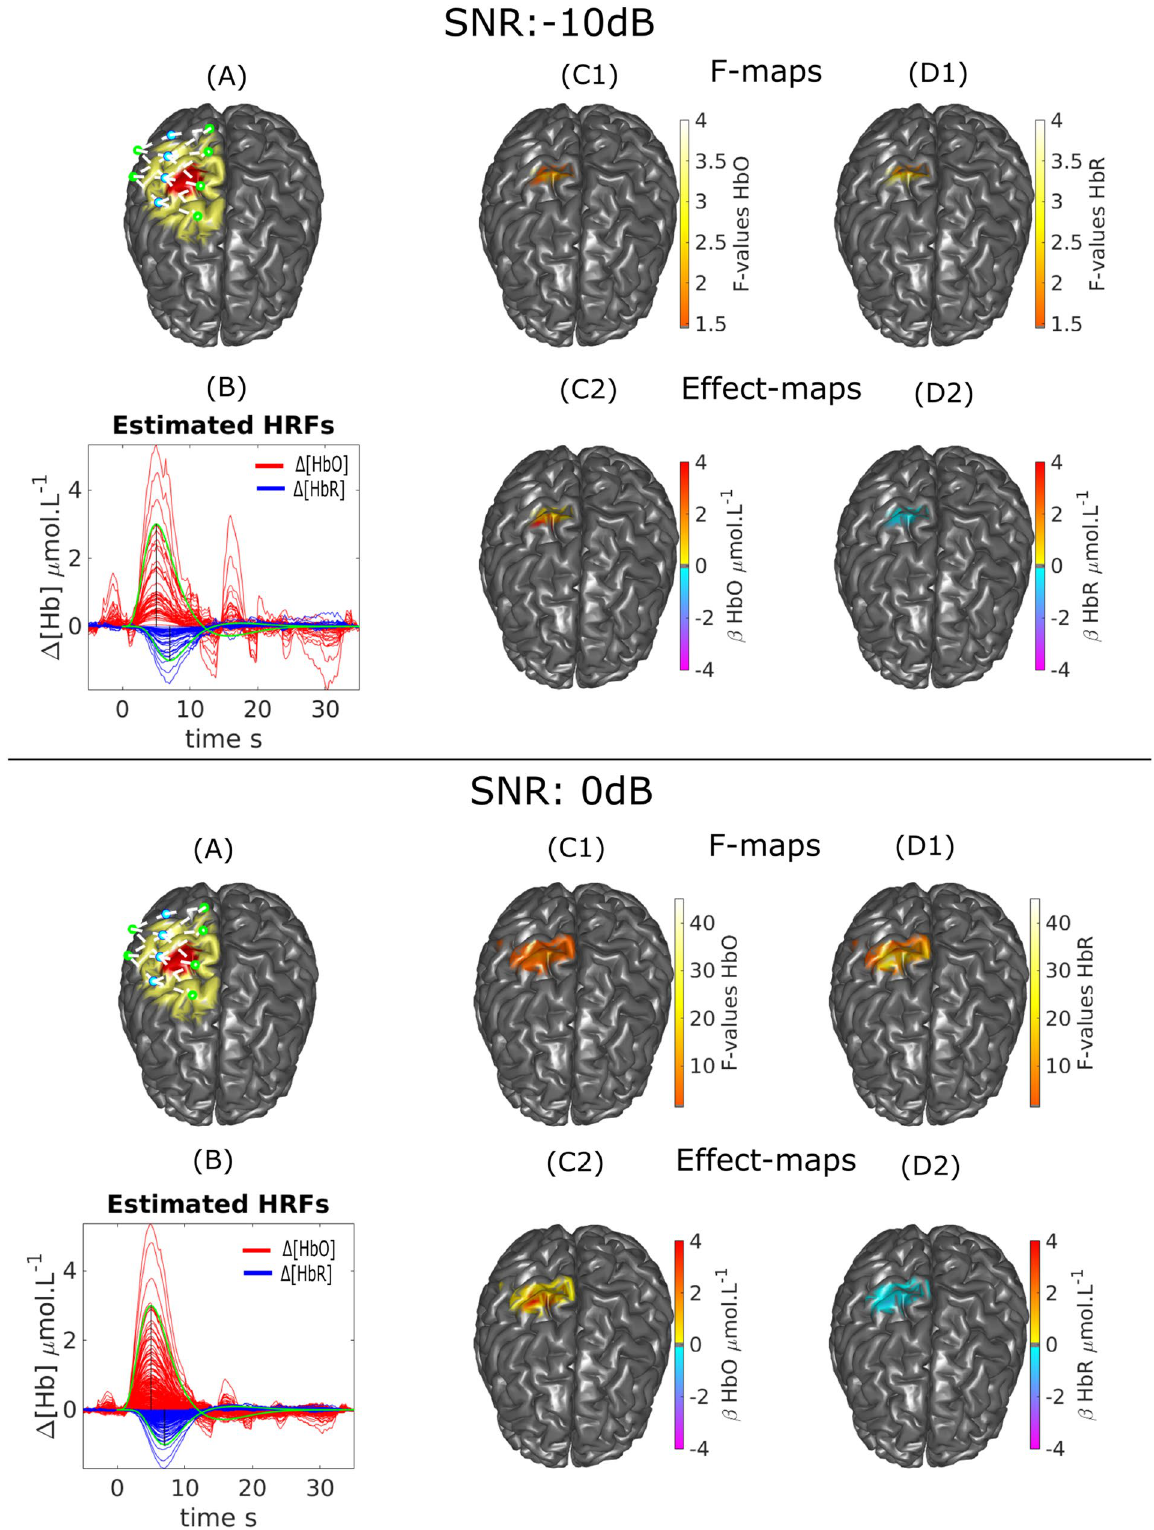
Figure 4. HRF deconvolution applied on DOT reconstruction on realistic simulations from one anatomical model obtained at two SNR levels (− 10 dB and 0 dB) ( A ) Optimal montage, simulated ROI (red) and FOV (yellow). ( B ) Estimated HRF time courses. HRF1 theoretical models simulated for either HbO/HbR are represented in green. ( C1 , C2 ) (cid:31) [ HbO ] : Thresholded F-map ( α = 0.05 , Bonferronni corrected) and associated effect size map estimated at TTP 1 = 6 s. ( D1 , D2 ) (cid:31) [ HbR ] : Thresholded F-map ( α = 0.05 , Bonferronni corrected) and associated effect size map estimated at TTP 1 = 8